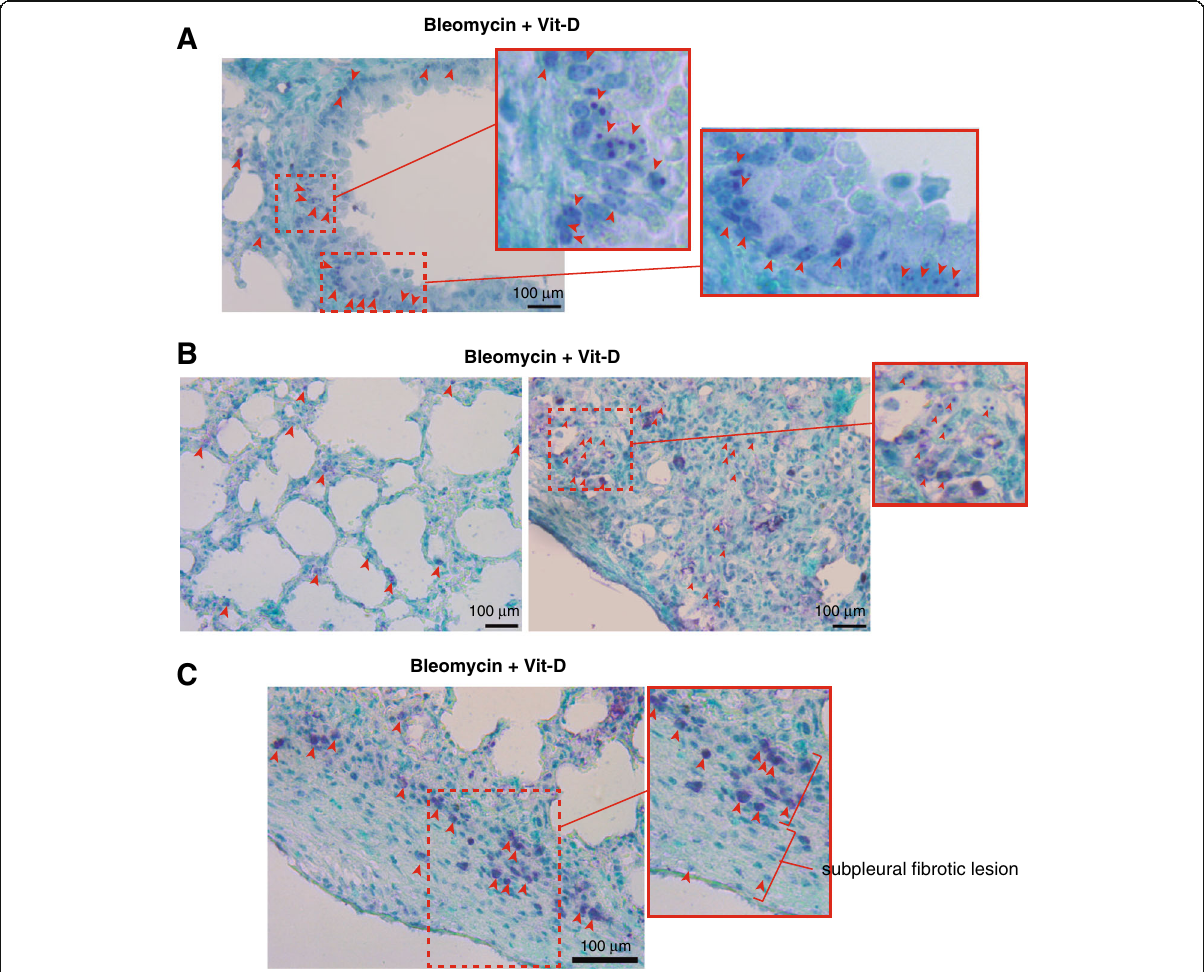
Fig. 9 Exacerbation of the DNA damage expression in lung tissue from mice treated with bleomycin and vitamin D. a Representative micrograph of a bronchiole surrounded by a fibrotic focus. Two magnifications of the image are depicted in the rectangles on the right. Arrowheads signal some of the multiple nuclei harboring DD foci containing γ H2AFX indicative of severe DNA damage. b Representative micrographs of interstitial fibrosis (left) and of an area abnormally re-epithelialized (right) showing the expression of massive DNA damage specially in the epithelial component. c Representative image of a subpleural fibrotic lesion lined by an abnormally re-epithelialized area showing the presence of severe DNA damage especially in epithelial cells. Scale bars: 100 μ